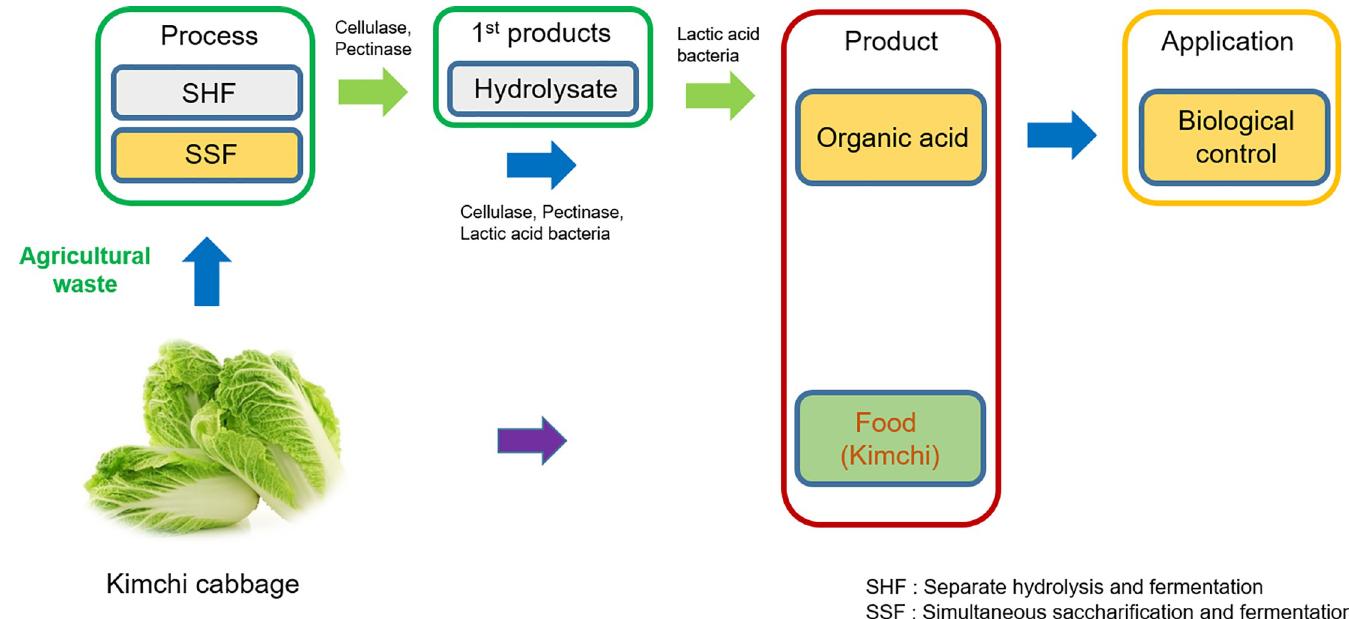
Fig 1. Schematic representation of the utilization of kimchi cabbage waste as a